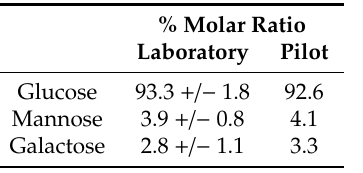
Table 3. Molar ratio (%) of monosaccharides in Pleuran CCWE. Data are means +/ − standard deviation ( n = 13 for laboratory